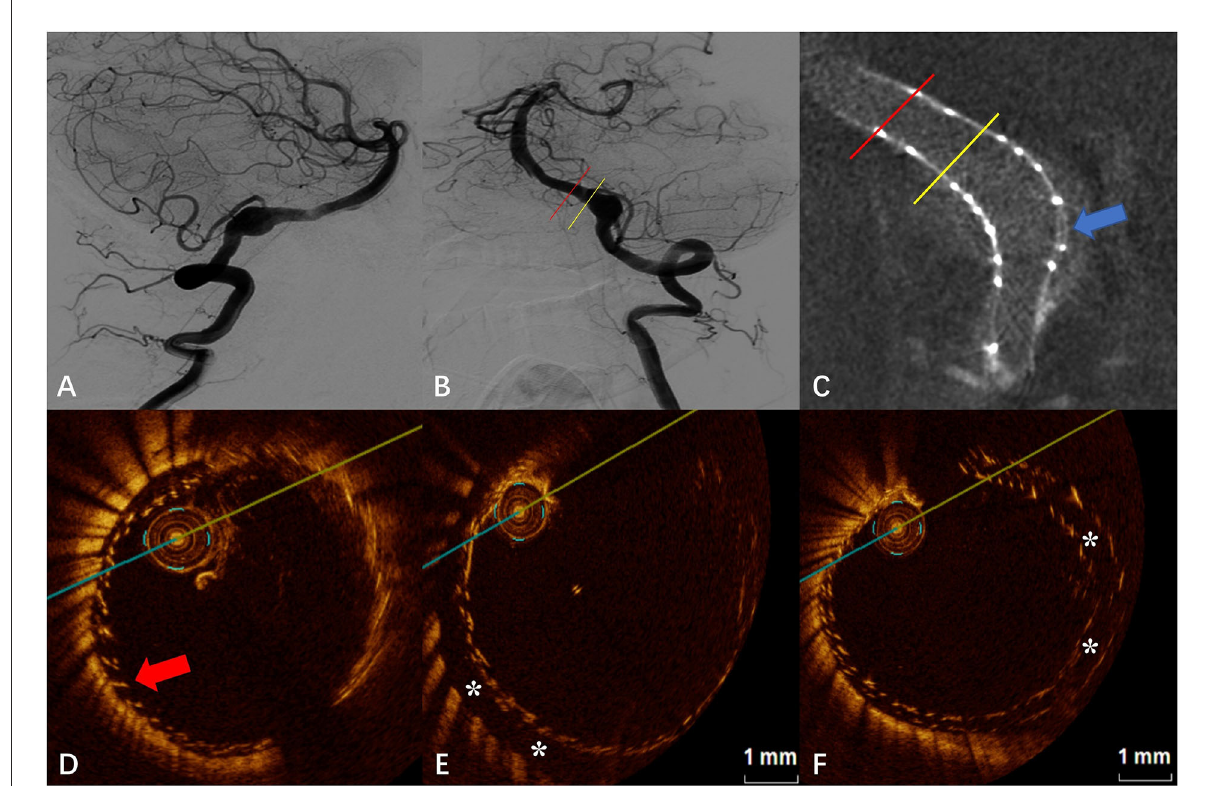
FIGURE4 (A) Digital subtraction angiography (DSA) before the flow-diverter placement. (B) Digital subtraction angiography (DSA) just after the flow-diverter placement. (C) Vaso CT image. Distal and proximal parent artery with good apposition of the FD to the wall. Malapposition between the stents at the aneurysm neck (blue arrow). (D) OCT image. The corresponding red line in (B,C) . Good apposition between stents and between the stent and the wall at the distal of the aneurysm neck (red arrow). (E) OCT image. The corresponding yellow line in (B,C) . Eccentric communication malapposition at the distal of the aneurysm neck (*). (F) OCT image. The corresponding blue arrow in (C) . Malapposition between the stents at the aneurysm neck